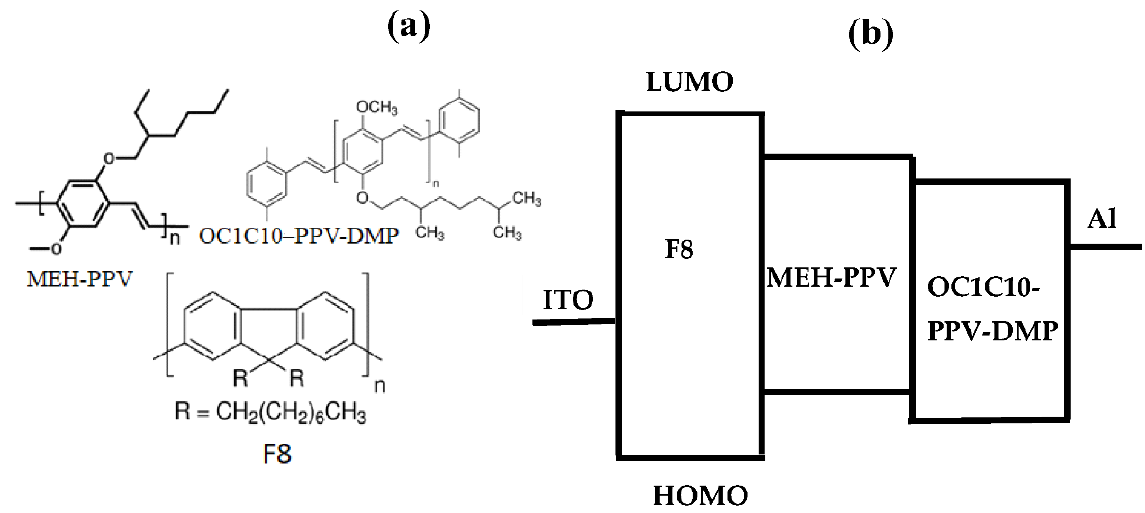
Figure 1. ( a ) Chemical structure of the F8, MEH-PPV and OC1C10 – PPV-DMP; ( b ) Energy levels schematic of all used materials.